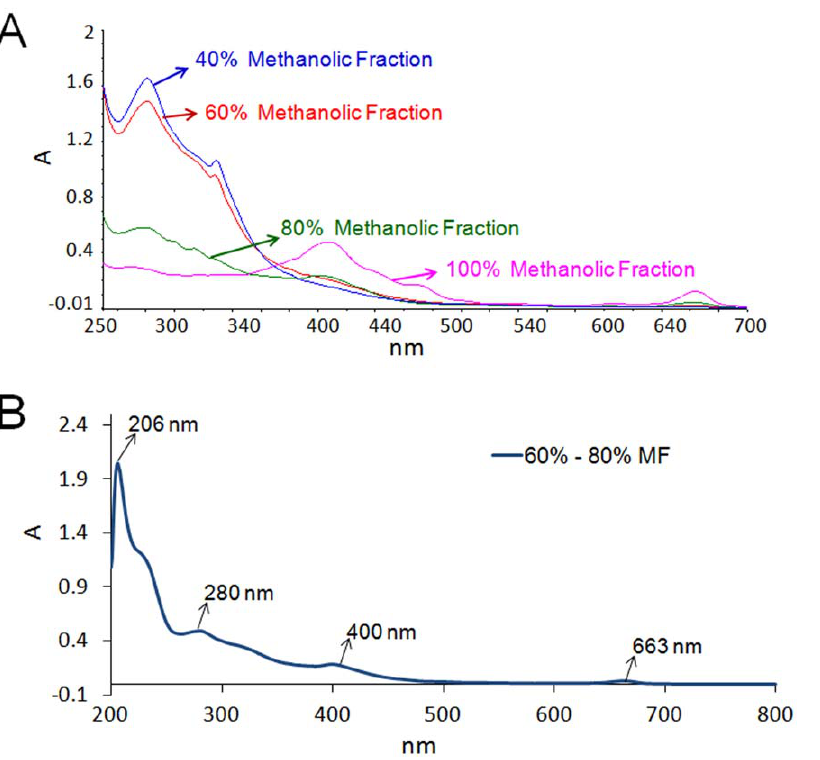
Figure 2. UV-visible spectra of fractions of Harshringar leaves extract. (A) Spectra of 40%, 60%, 80%, 100% MF were recorded against methanol as blank. 110 m g/mL, 90 m g/mL, 180 m g/mL, 80 m g/mL of 40%, 60%, 80%, 100% MF respectively were used for spectral studies. (B) UV- visible spectra of pool of 60%–80% MF (40 m g/mL).